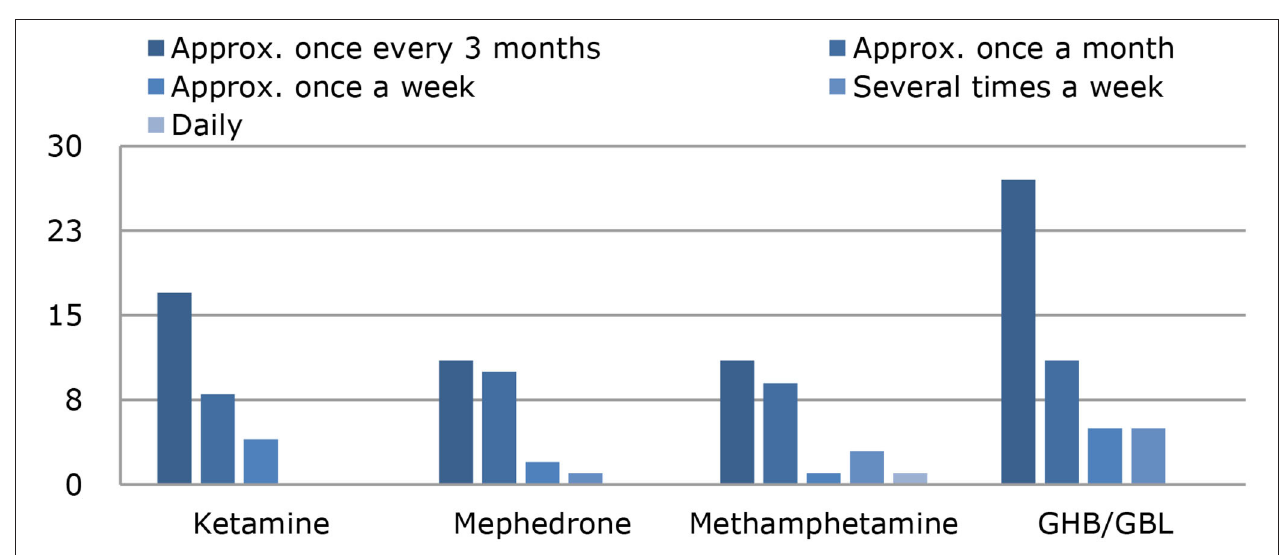
FIGURE 1 | Frequency distribution of the item: “within the last 12 months I had sex under the influence of drugs”.